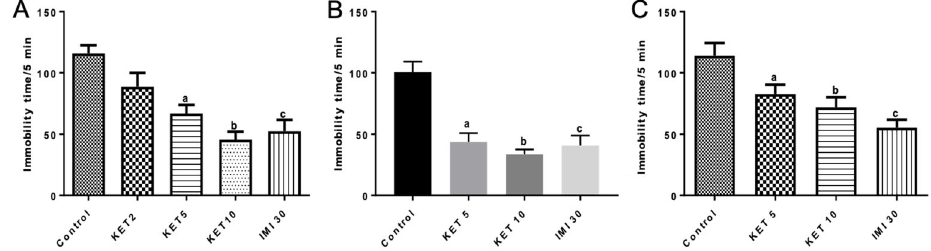
Figure 2. Antidepressant-like effects of single administrations of ketamine (KET, 5 and 10 mg/kg) evaluated by the forced swim test in male mice (7 to 10 animals per group) 30 min ( A ), 15 days ( B ), and 30 days ( C ) later. Data are reported as means ± SE. A , a,b,c P o 0.05 vs Control; B and C , a,b,c P o 0.001 vs Control (one-way ANOVA and Tukey as the post hoc test).